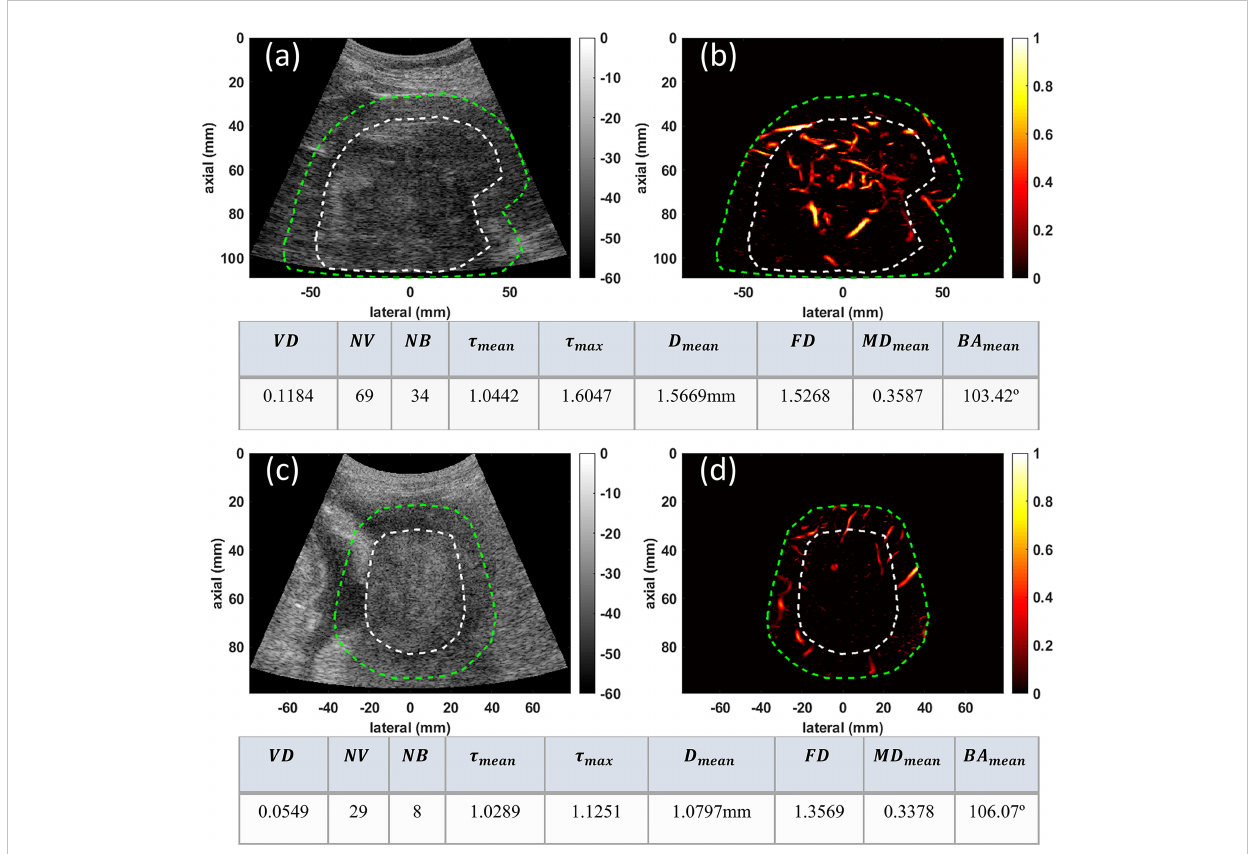
FIGURE 2 Examples of visualization and quanti fi cation results for two malignant lesions. (A) B-mode image of a 94mm HCC tumor (B) Microvasculature image inside the dilated HCC tumor mask (C) B-mode image of a 51mm CCA lesion (D) Microvasculature image inside the dilated CCA tumor mask. In all images the white dashed line indicates the boundaries of the lesion, and the green dashed line delineates the boundaries after a 10mm dilation. The tables below each row of images show metric values for the HCC (top) and CCA (bottom)